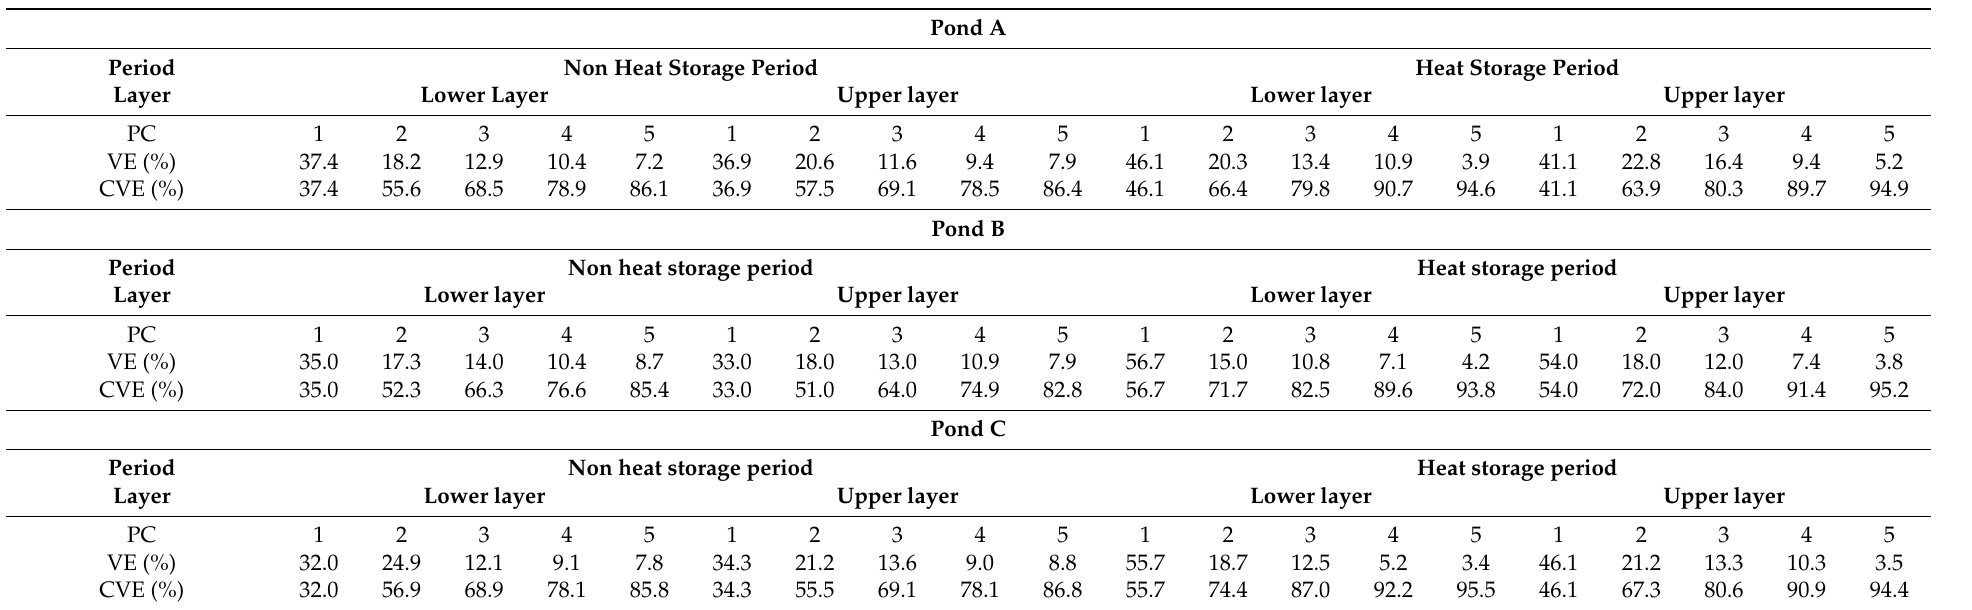
Table 5. Variance explained by the 1st to 5th principal